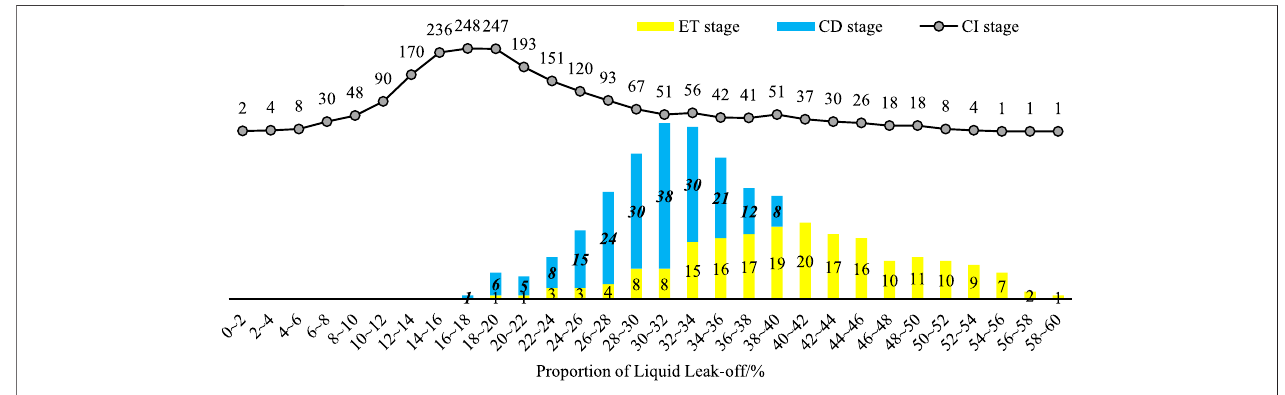
FIGURE 4 | Distribution of fracture stages with different proportion of liquid leak-off time.